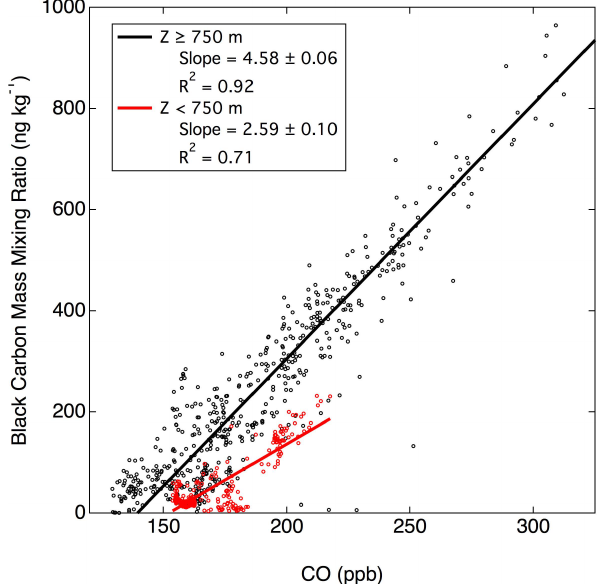
Fig. 7. Correlation between BC mass mixing ratio and CO mix- ing ratios for the flight of 21 April 2008. The 30s data points are discriminated by altitude at 750m. The slope with one standard deviation and the R 2 value is shown for each linear regression.